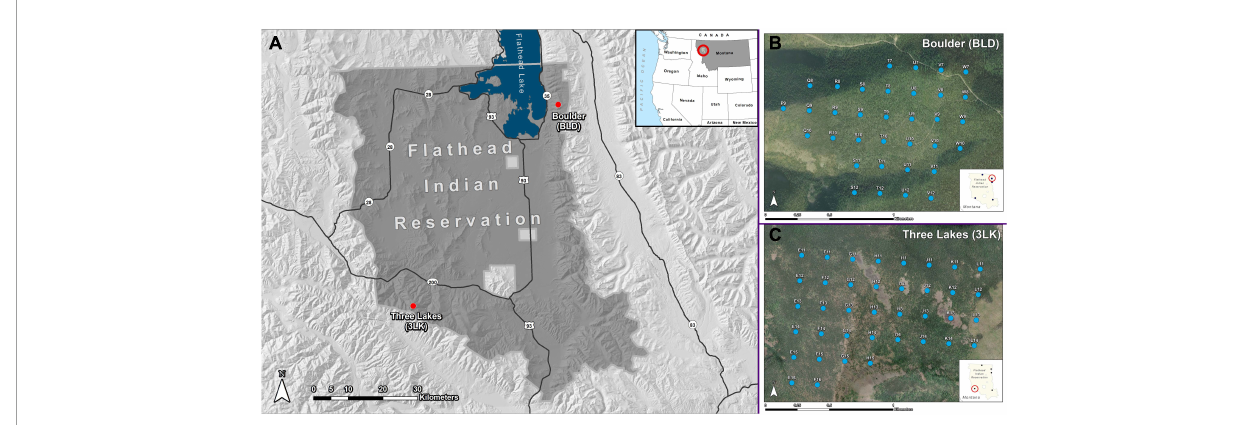
FIGURE1 Flathead Indian reservation in northwestern Montana with the two sites (A) and a detailed map of the Boulder (BLD) study site (B) and three Lakes (3LK) study site (C) . Permanent plots (blue circles) were located on a 200 m grid as part of a larger fire history reconstruction project for the confederated Salish and Kootenai Tribes. Plots cover approximately 100 ha at 3LK and 88 ha at